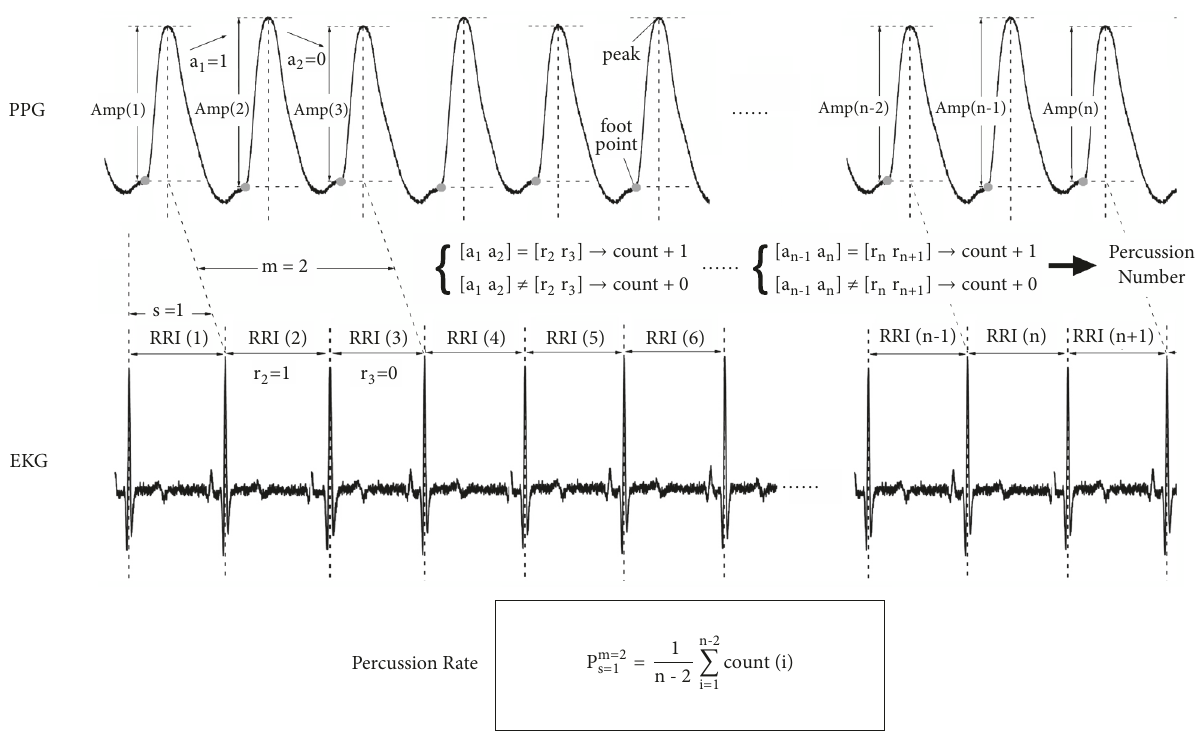
Figure 1: Computation of percussion rate by matching changes in the amplitudes (Amp, defined as the height of a waveform from foot point to peak) of n successive photoplethysmography (PPG)-acquired digital volume pulse (DVP) waveforms with changes in R-R intervals (RRI) using a shift number (s) of 1 and the dimension of vector pattern (m) (i.e., impact points) of 2. Note that n = 1000 for the present study. PPG: photoplethysmography; EKG: electrocardiogram; Amp(n): amplitude of DVP waveform during n th cardiac cycle; RRI(n): R-R intervalduring n th cardiac cycle; a: binary code denoting increase (i.e., 1) or decrease (i.e., 0) in amplitude when compared with the previous waveform; r: binary code denoting increase (i.e., 1) or decrease (i.e., 0) in RRI when compared with the previous cardiac